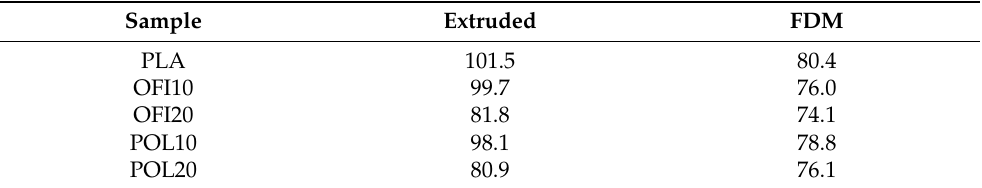
Table 7. Molecular weights, expressed in kDa, of extruded (single-screw extrusion) and FDM samples. Sample